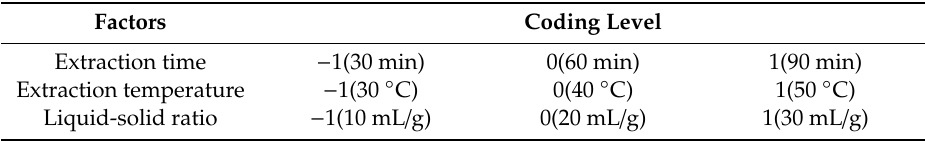
Table 4. Box-behnken design table of factors and